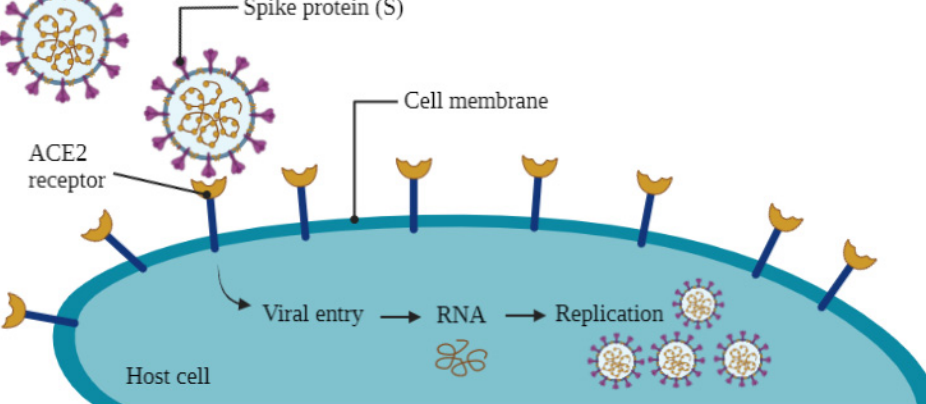
Figure 2. How the SARS-CoV-2 virus enters and infects human cells .